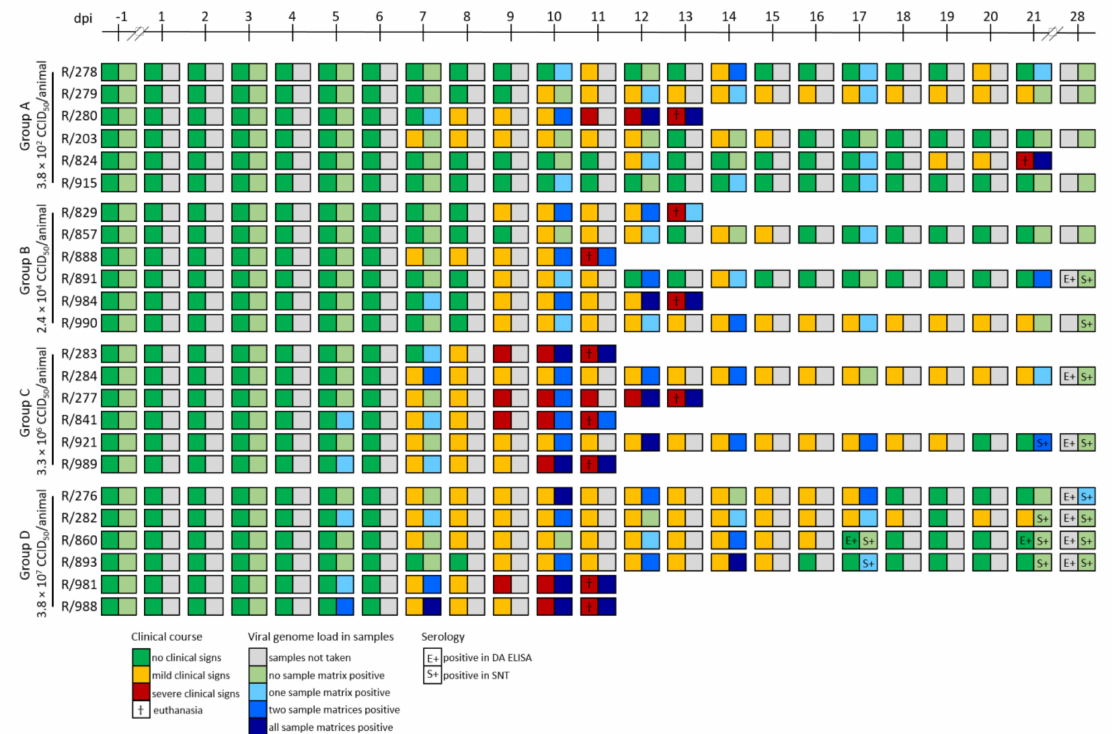
Figure 3. Summary graph of clinical, molecular and serological data. Clinical scores and body temperatures were measured daily during the animal trial. At certain days post infection, Ethylenediaminetetraacetic acid (EDTA) blood, serum, as well as nasal swab samples were